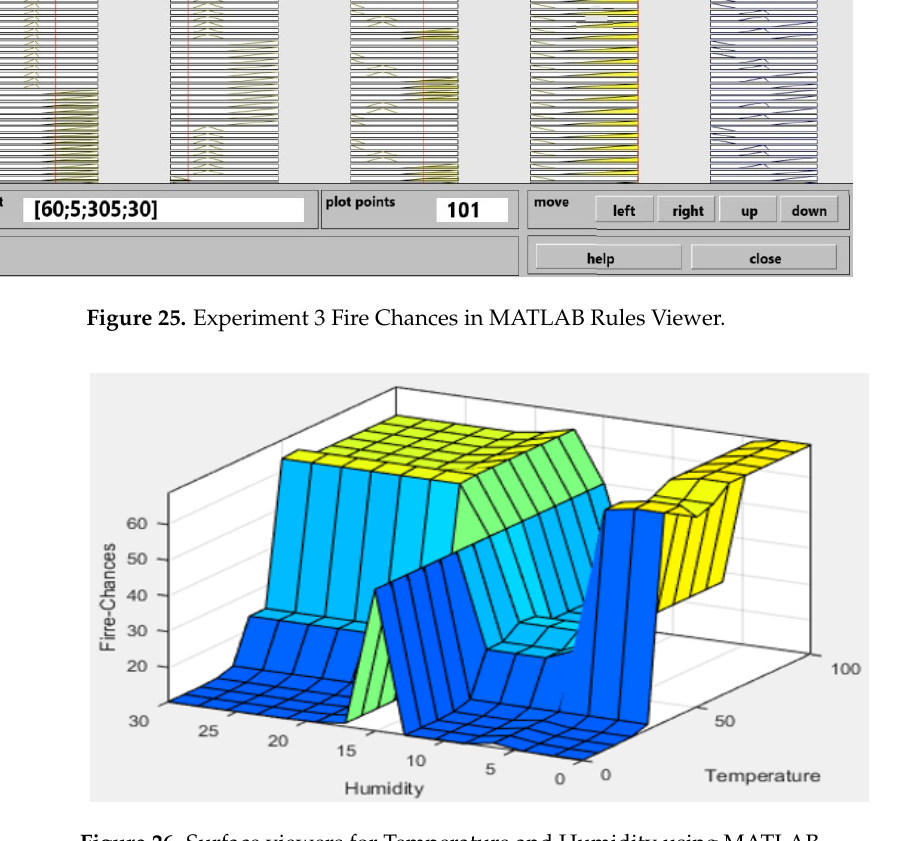
Table 9. Results of 15 experiments based on SMDD. Figure 26. surface viewers for Temperature and Humidity using MATLAB.